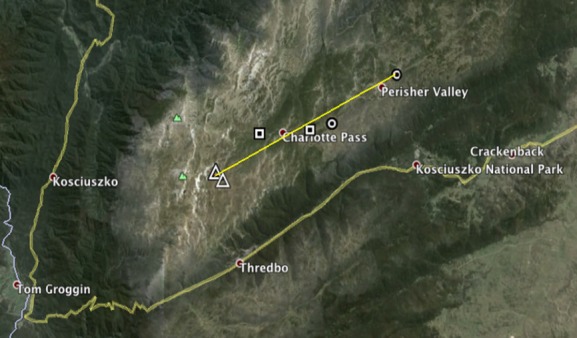
Map of seed collection points. Each point includes 2–3 plants selected at least 10 m apart. High, medium, and low-elevation sites are indicated by triangles, squares, and circles, respectively. The length of the yellow line is approximately 14 km. Red dots indicate other local landmarks including the peak of Mt Kosciuszko, the highest point in Australia.